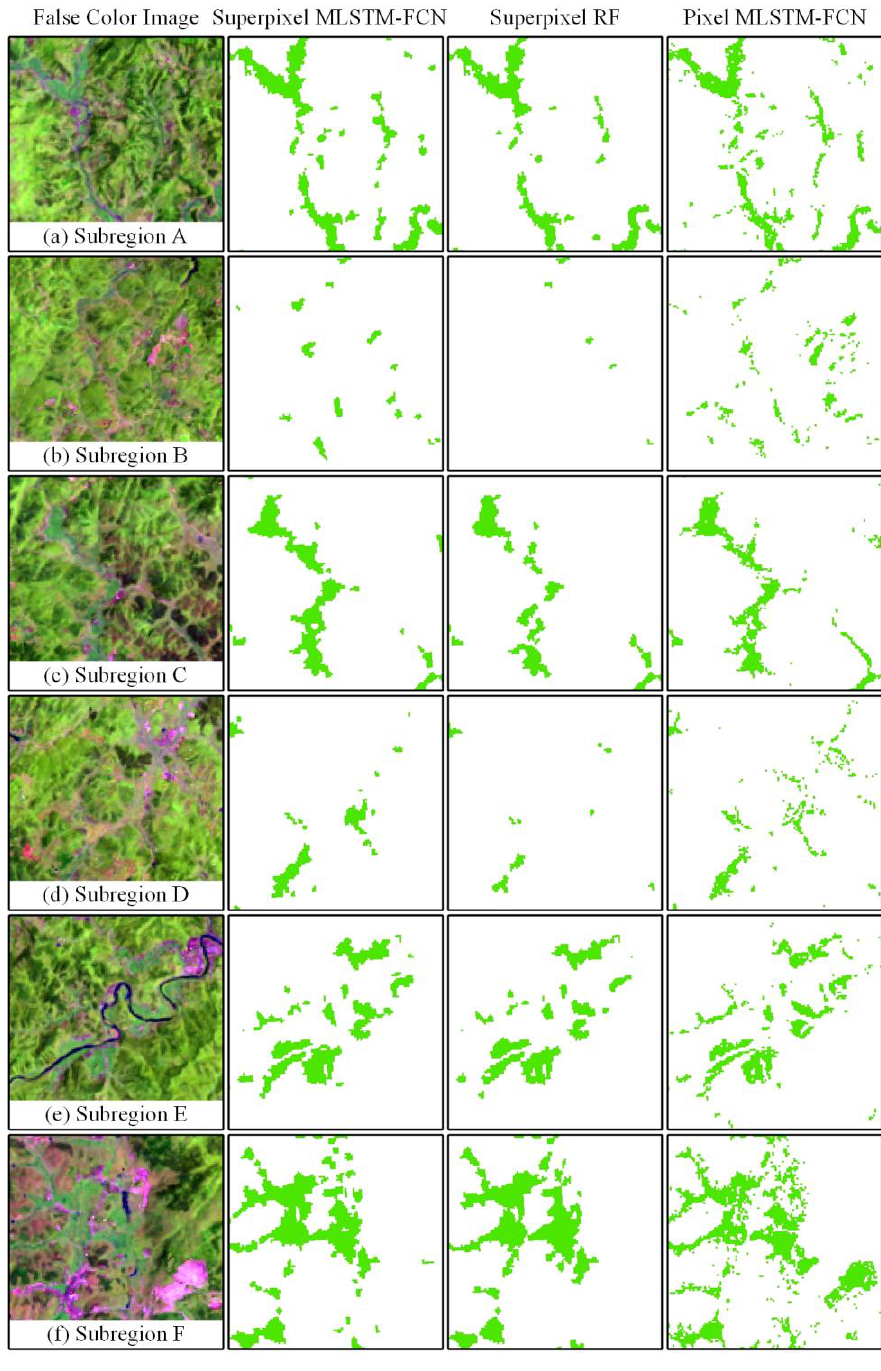
Figure 9. Local details of paddy rice mapping results of different classifiers in 2020, ( a – f ) represent the detailed information at subregion A to subregion F, respectively. False color image was composite by synthetic Landsat surface reflectance image on 28 July 2020 (R: SWIR 1, G: NIR, B: Green).